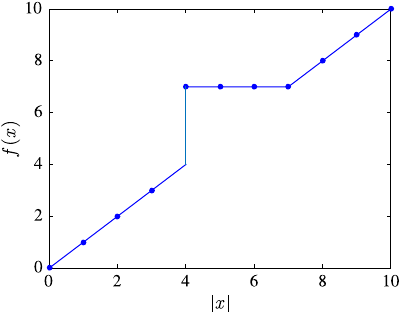
FIG. 1. Fixed plateau cost function with l ¼ 3 , u ¼ 8